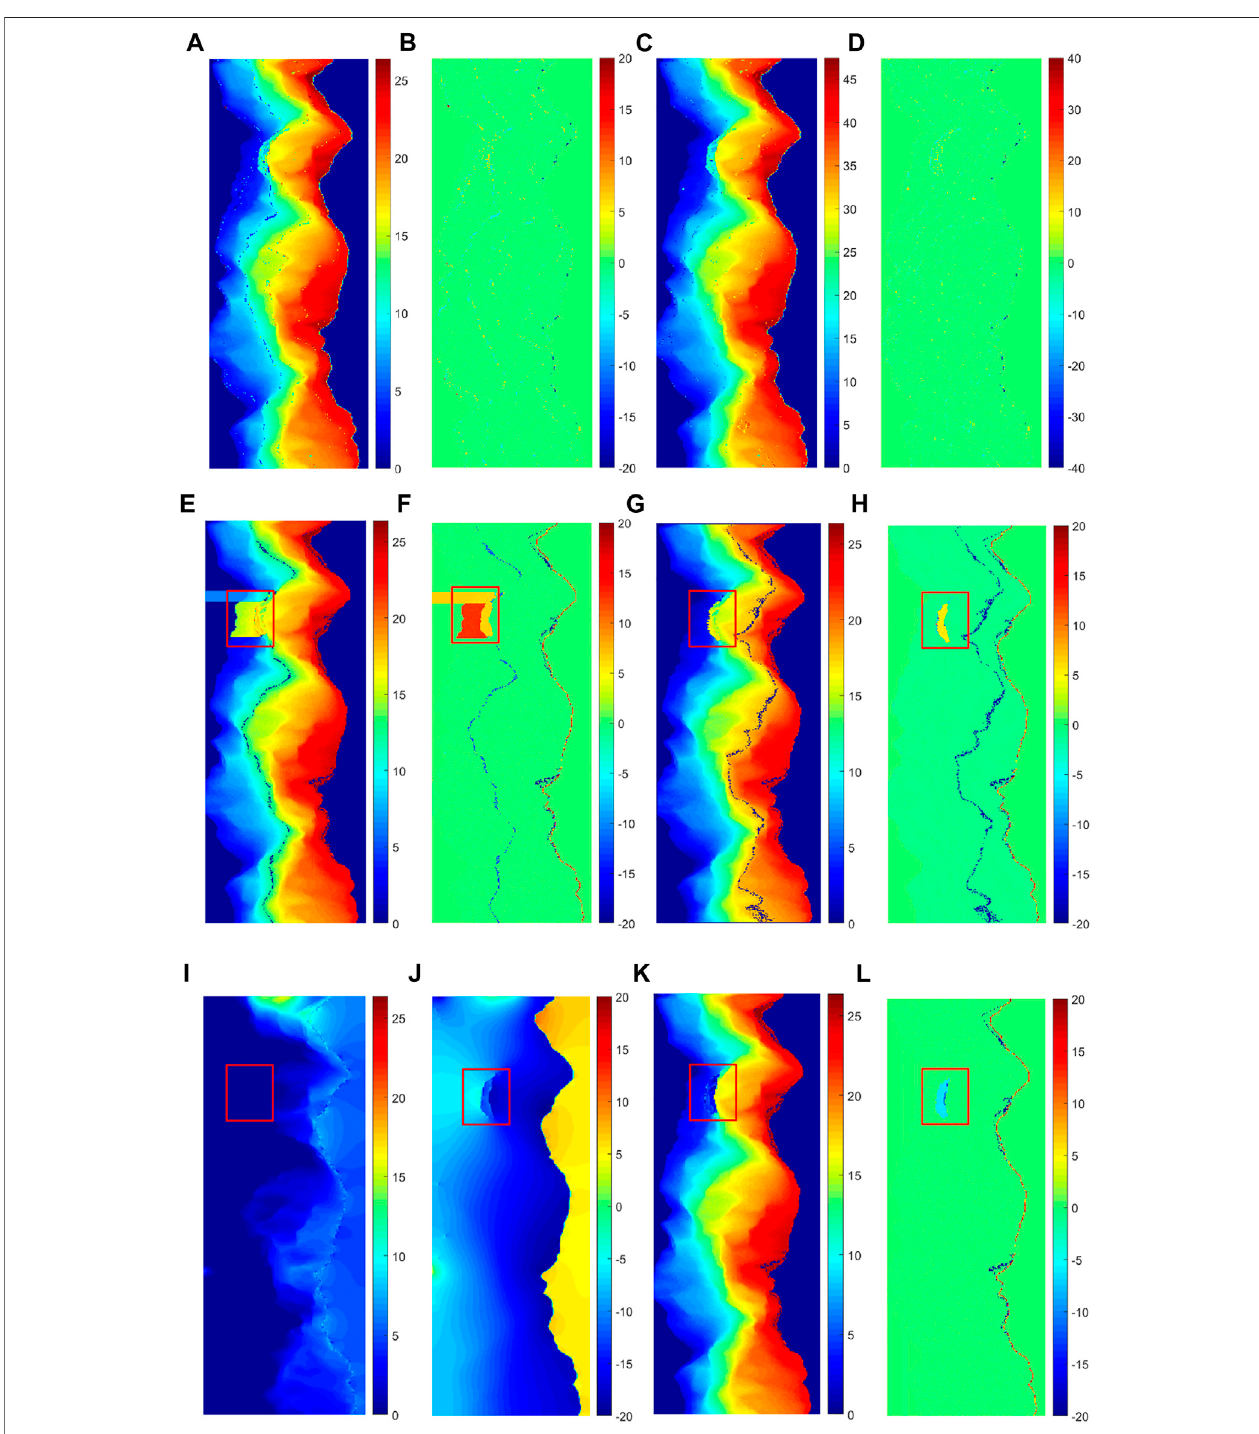
FIGURE 13 | (A) Unwrapping results of the PIP method based on 105 m baseline (rad). (B) Phase error distribution map of the PIP method based on 105 m baseline (rad). (C) Unwrapping results of the PIP method based on 189 m baseline (rad). (D) Phase error distribution map of the PIP method based on 189 m baseline (rad). (E) Unwrappingresultsofthebranch-cutmethod based on105 m baseline (rad). (F) Phaseerrordistributionmap ofbranch-cutmethod basedon105 mbaseline (rad). (G) Unwrappingresultsofthequality-guided method basedon105 mbaseline (rad). (H) Phaseerrordistribution mapofthequality-guidedmethodbasedon 105 m baseline (rad). (I) Unwrapping results of the LS method based on 105 m baseline (rad). (J) Phase error distribution map of the LS method based on 105 m baseline (rad). (K) Unwrapping results of the MCF method based on 105 m baseline (rad). (L) Phase error distribution map of the MCF method based on 105 m baseline